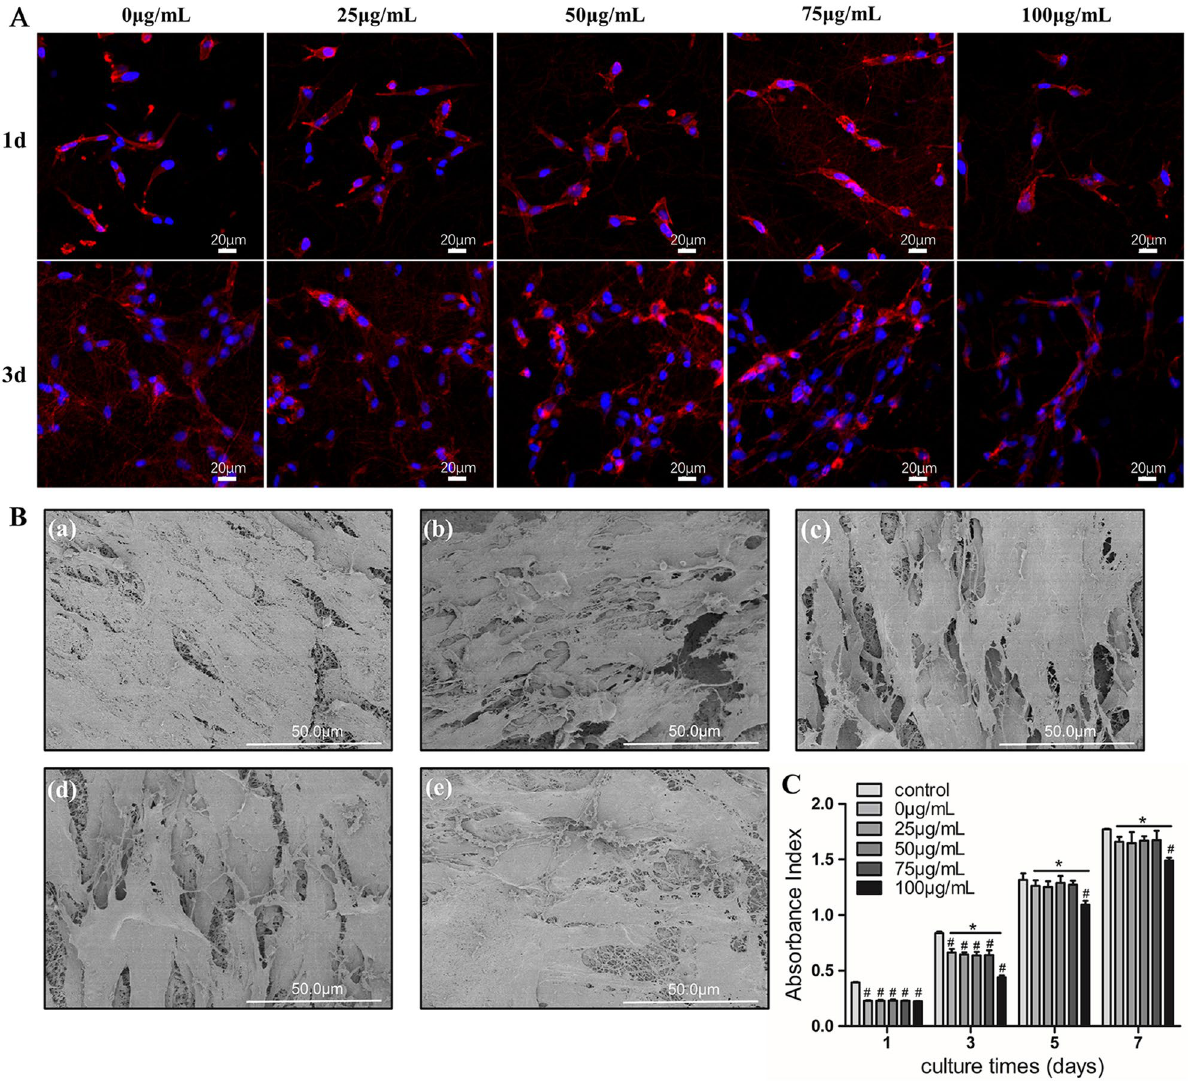
Figure 3. The morphology and proliferation of DPSCs cultured on scaffolds. ( A ) DAPI and actinred immunocytochemical staining of DPSCs co-cultured on scaffolds after 1 day and 3 days. ( B ) The morphology of DPSCs cultured on scaffolds for 7 days. ( a ) PCL/COL scaffold; ( b , c , d , e ) BBR/PCL/COL (25, 50, 75 and 100 μg/ mL) scaffolds. ( C ) Proliferation rate of DPSCs cultured on the different scaffolds at days 1, 3, 5, 7. “#” means the comparison between the control group and the experimental group, P < 0.05; “*” means the comparison between experimental groups, P < The proliferation of DPSCs cultured on scaffolds. The proliferation of DPSCs seeded on PCL/COL scaffold and BBR/PCL/COL (25, 50, 75 and 100 μg/mL) scaffolds were measured quantitatively by cell counting kit-8 (CCK8) assay. The cellular metabolism was detected on day 1, 3, 5, 7, and the result indicated that cellular proliferation was stable in all groups (Fig. 3C). On day 1 and 3 cellular proliferation in the scaffold groups were lower than control group, no significant difference was found between the experimental groups on day 1 and 3 ( P > 0.05). The reason speculated was that the bottom of the plate was designed to facilitate cell adhesion, so the proliferation of cells occurred earlier. Compared with the PCL/COL scaffold group, the BBR/PCL/COL scaffold with the concentration of 100 μg/mL showed poor performance at day 3, 5 and 7 ( P < 0.05), which may cause by the increasing concentration of drug. Therefore, we considered that DPSCs have favorable biocompatibility in PCL/COL scaffold and BBR/PCL/COL scaffolds with the BBR concentration of 25–75 μg/mL. Osteogenic differentiation of DPSCs cultured in scaffolds. In order to investigate the effect of PCL/ COL scaffold and BBR/PCL/COL (25, 50, 75 and 100 μg/mL) scaffolds on osteogenic differentiation of DPSCs, we seeded DPSCs on the scaffolds and cultured with osteogenic induction. Figure 4A(a, b) was the results of alkaline phosphatase activity (ALP activity) on day 7 and 14. On day 7, the activity of ALP in BBR/PCL/COL scaffold groups were significantly higher than that in the PCL/COL scaffold group. However, the promoting